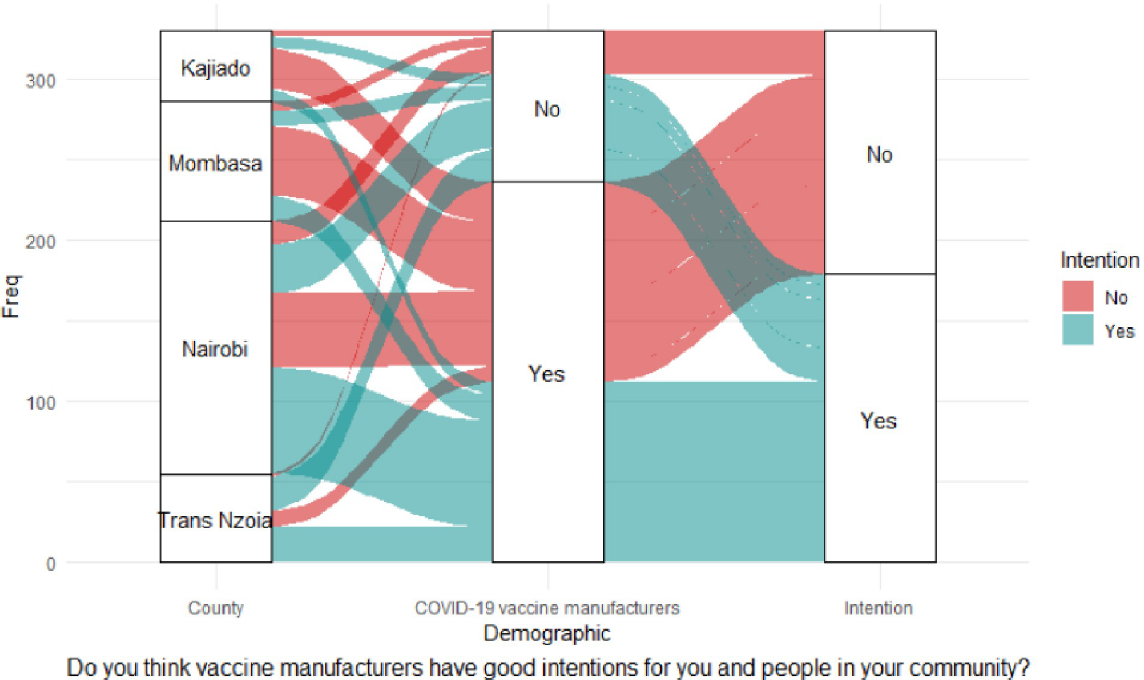
Fig 2. Trust in good intention of vaccine manufacturers.